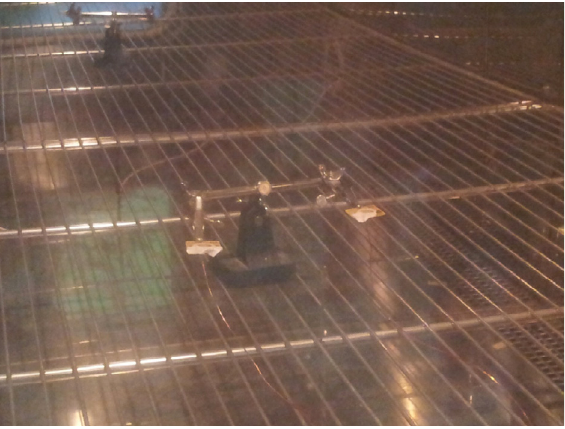
Fig. 5. Specimens under test.